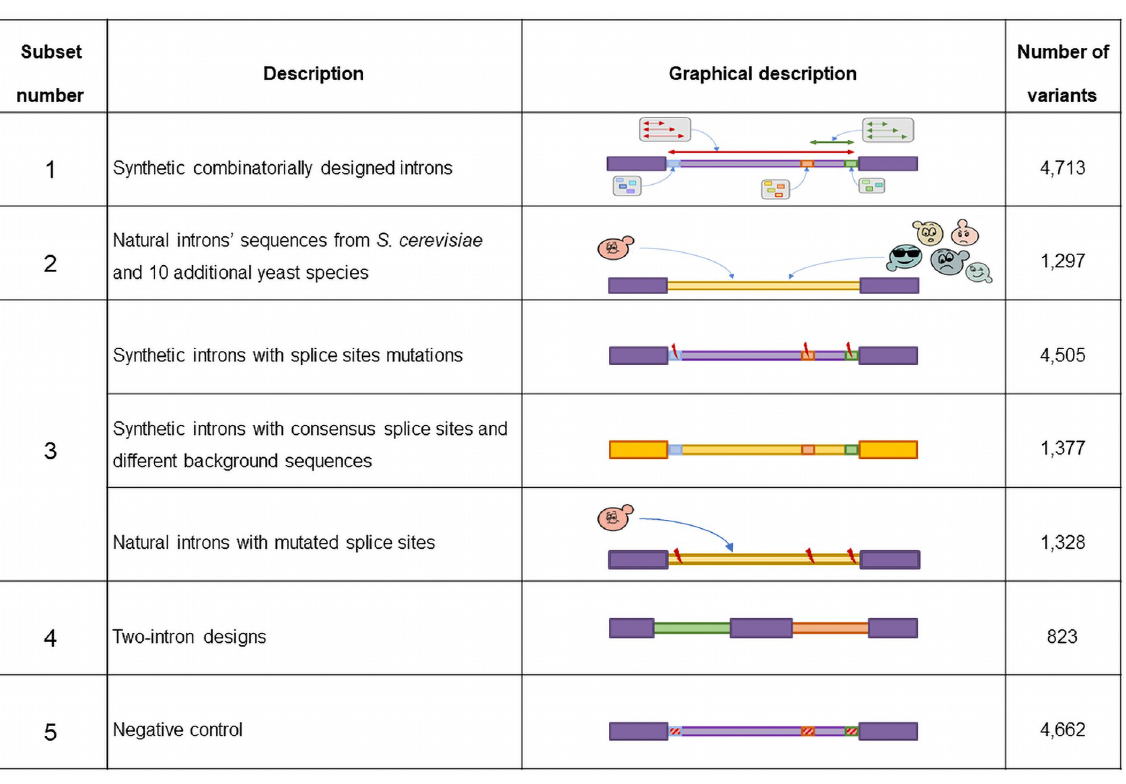
Fig 2. Summary table of the different subsets composing the library and the number of variants in each of them.